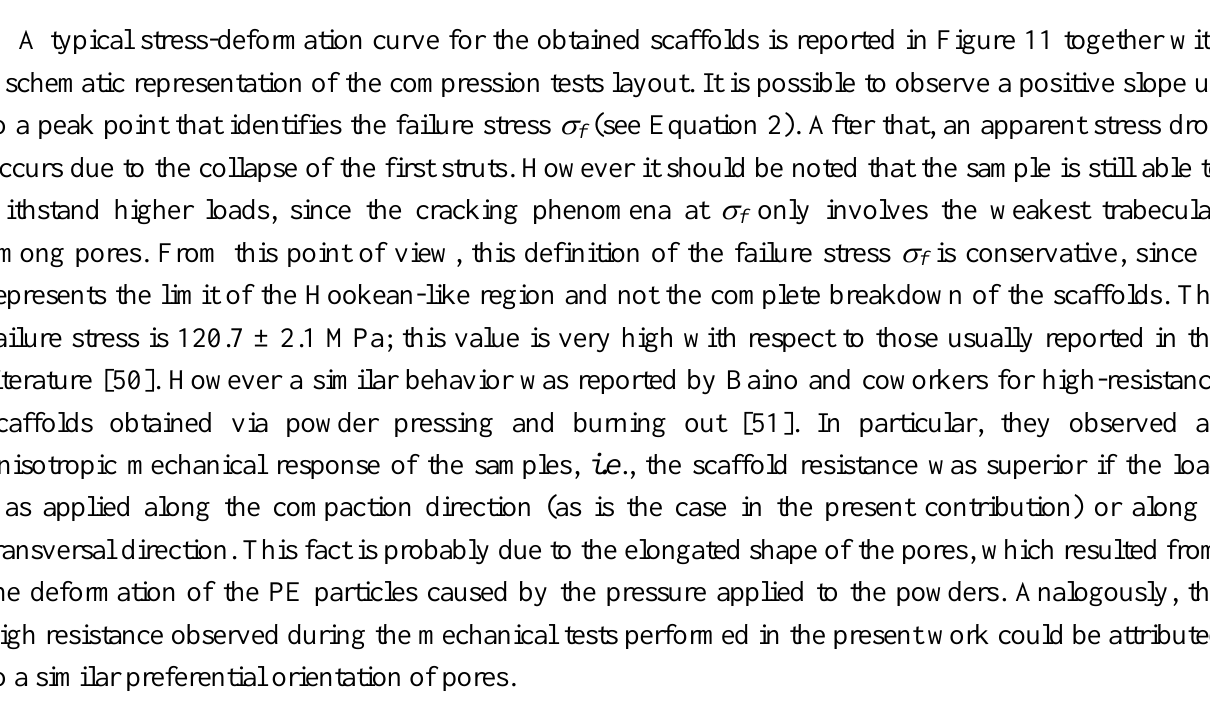
Figure 11. (a) Schematic representation of the compression tests layout. (b) Stress-deformation curve for a scaffold treated at 750 °C for 3